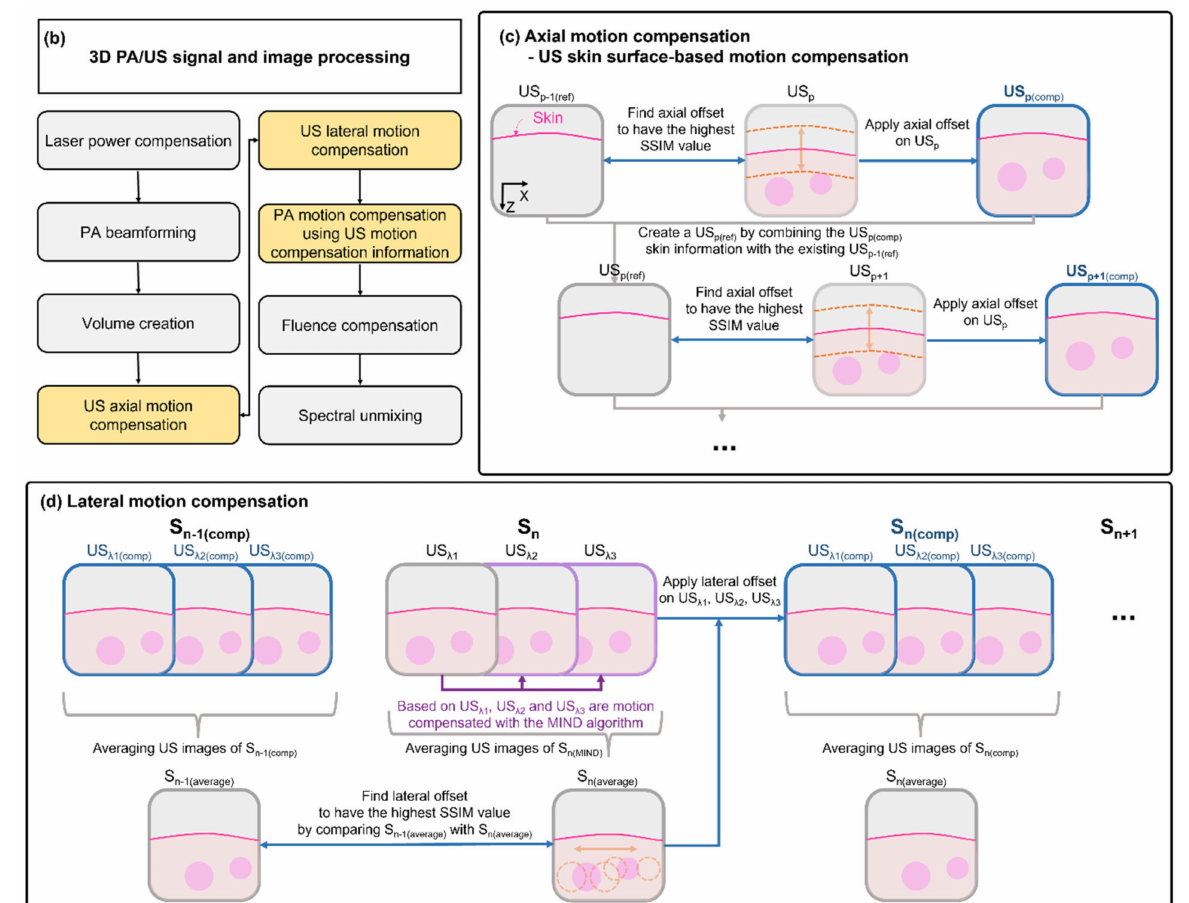
Figure 2. Schematics of ( a ) acquisition of 3D multi-wavelength PA/US images, ( b ) 3D PA/US signal and image processing, ( c ) axial motion compensation, and ( d ) lateral motion compensation. US p , US p(ref) , and US p(comp) represent the pth acquired US image, the reference image for the following axial motion compensation of US image, and the axial-motion-compensated US image, respectively. S n , S n(MIND) , S n(average) , and S n(comp) represent the US images included in the nth scanning period, the MIND-corrected US images of the nth scanning period, the average US image of the nth scanning period, and the lateral-motion-compensated US images of the n th scanning period, respectively. US λ 1 , US λ 2 , and US λ 3 represent the US images obtained at three optical wavelengths (756, 797, and 866 nm, respectively). Note that the US images are not affected by the optical wavelengths. PA: photoacoustic; US: ultrasound; ROI: region of interest; SSIM: the structural similarity index measure; and MIND: modality independent neighbourhood